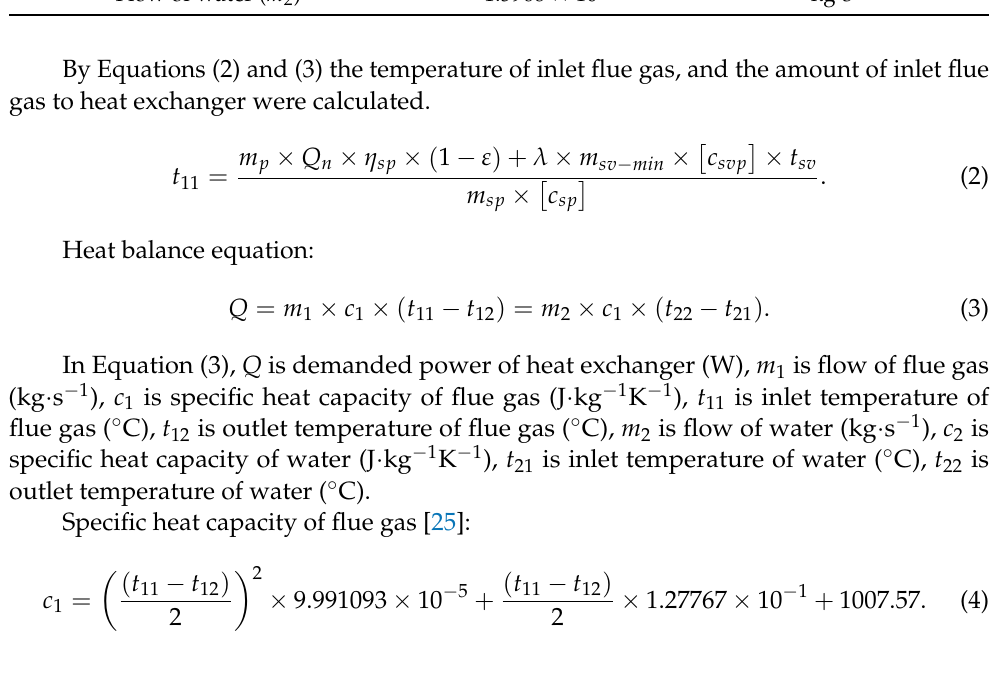
Table 2. Heat exchanger design inputs. Parameter Value Unit Inlet temperature of flue gas ( t 11 ) 1040 ◦ C Outlet temperature flue gas ( t 12 ) 150 ◦ C Inlet temperature of water ( t 21 ) 50 ◦ C Outlet temperature of water ( t 22 ) 80 ◦ C Demanded heat power ( Q ) 20 kW Calculated Parameter Value Specific heat capacity of flue gas ( c 1 ) 1118.68 J · kg − 1 K − 1 Specific heat capacity of water ( c 2 ) 4180.56 ◦ C Flow of flue gas ( m 1 ) 2.0128 × 10 − 2 kg · s − 1 Flow of water ( m 2 ) 1.5968 × 10 − 1 kg · s −